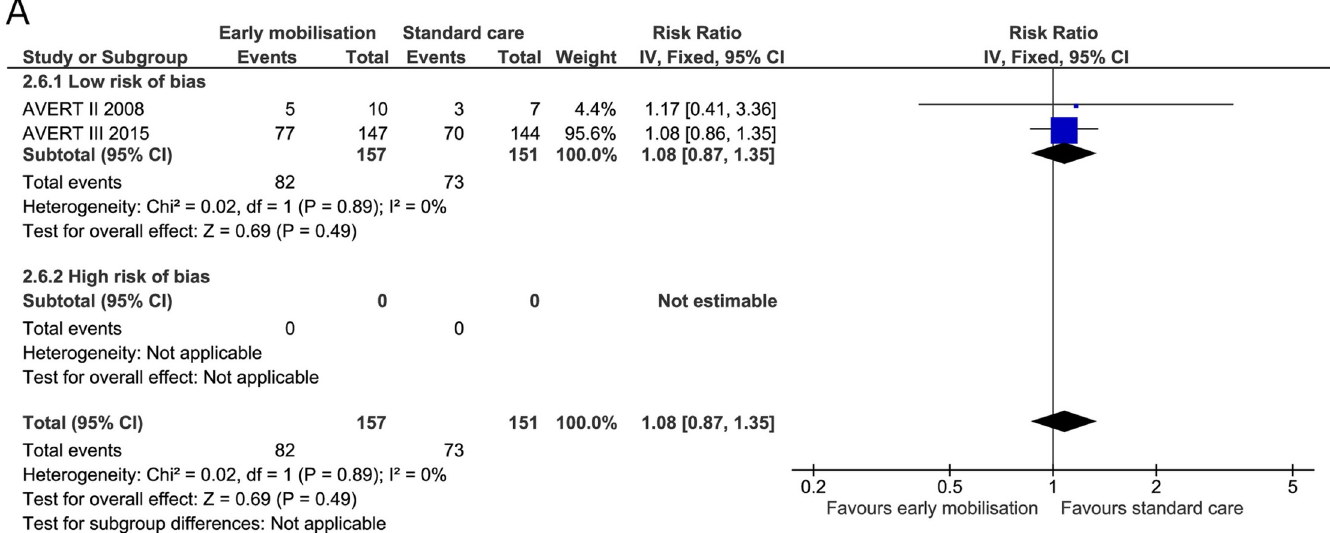
Fig 12. Comparison of early mobilisation versus standard care–Serious adverse events at maximal follow-up. Fig 12 A. Forest-plot showing the results from the fixed-effect meta-analysis of the outcome serious adverse events at the longest follow-up with subgroup divided according to low risk of bias or risk of bias.